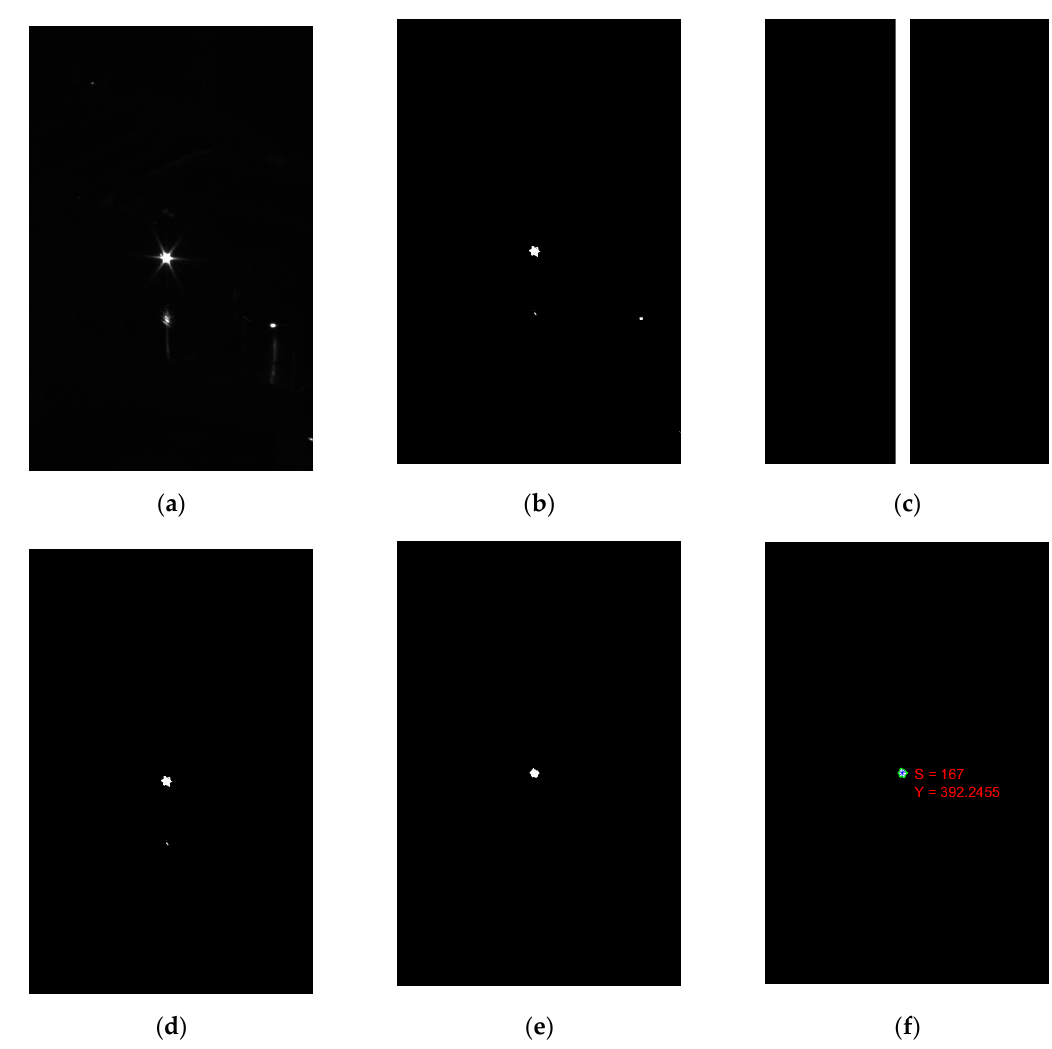
Figure 6. Image sequence ( a ) original image; ( b ) binarized image; ( c ) region of interest (ROI) filter; ( d ) image after ROI-limited; ( e ) image after corrosion and expansion; ( f ) extracted Y position and speckle size S.